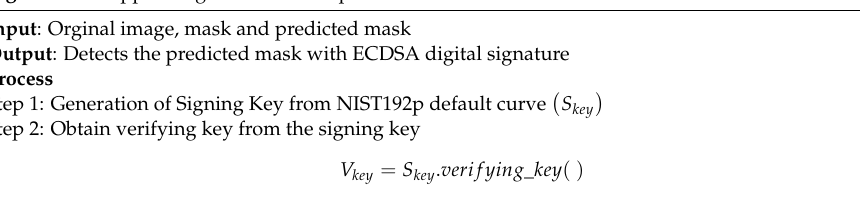
Algorithm 2: Appending ECDSA to the predicted